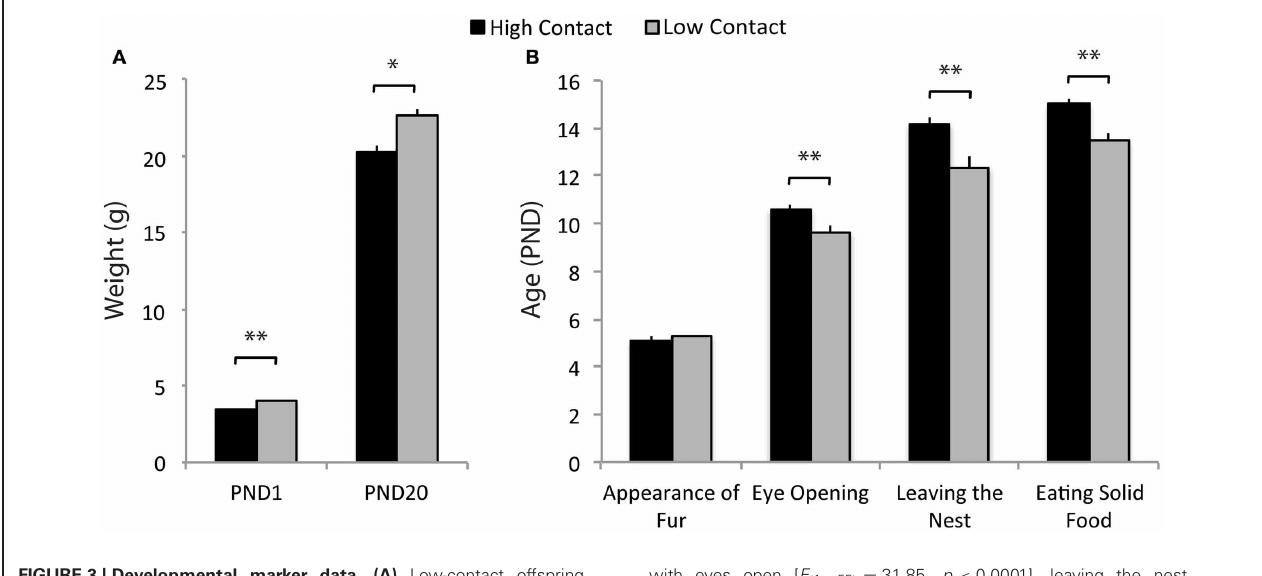
FIGURE 3 | Developmental marker data. (A) Low-contact offspring had higher weights on PND1 [ F ( 1 , 59 ) = 36 . 17, p < 0 . 0001] and at weaning [ F ( 1 , 63 ) = 10 . 07, p = 0 . 0023] compared to high-contact offspring. (B) Low-contact offspring were observed at younger ages